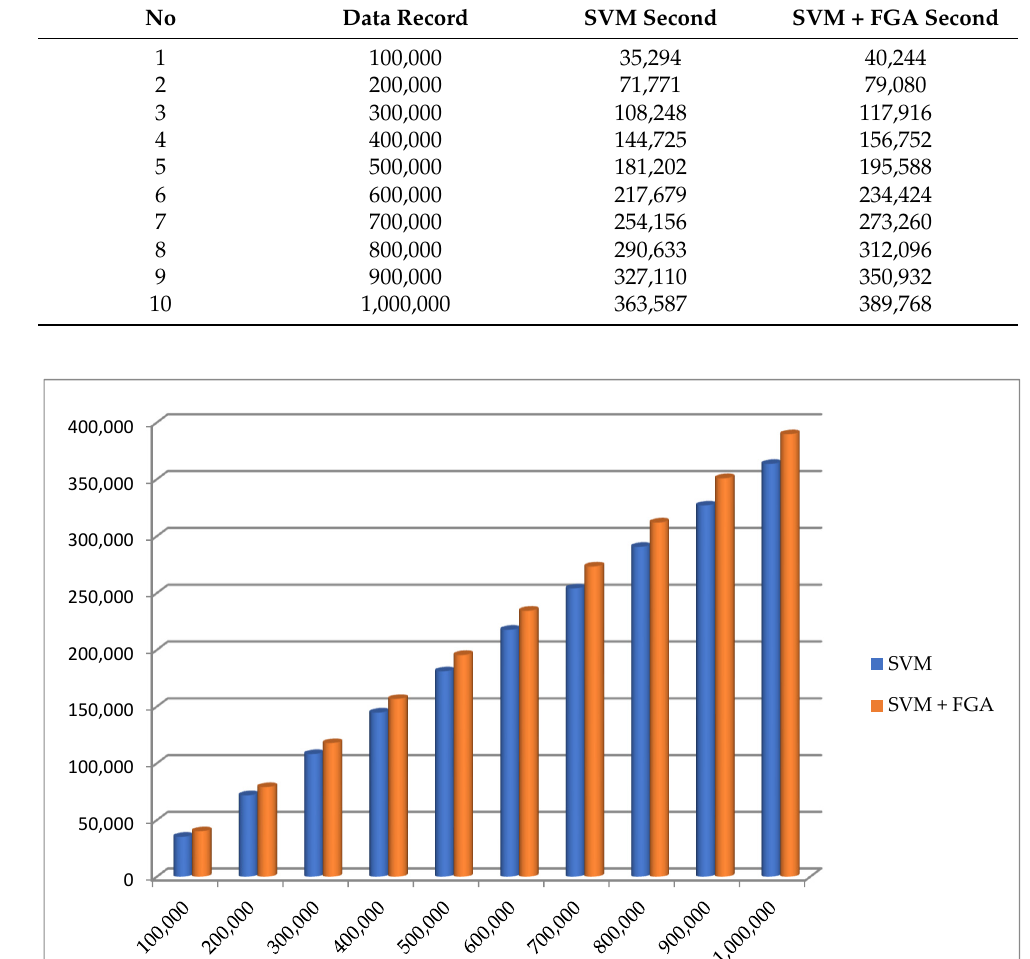
Table 4. Table of computational performance of SVM and SVM using FGA.